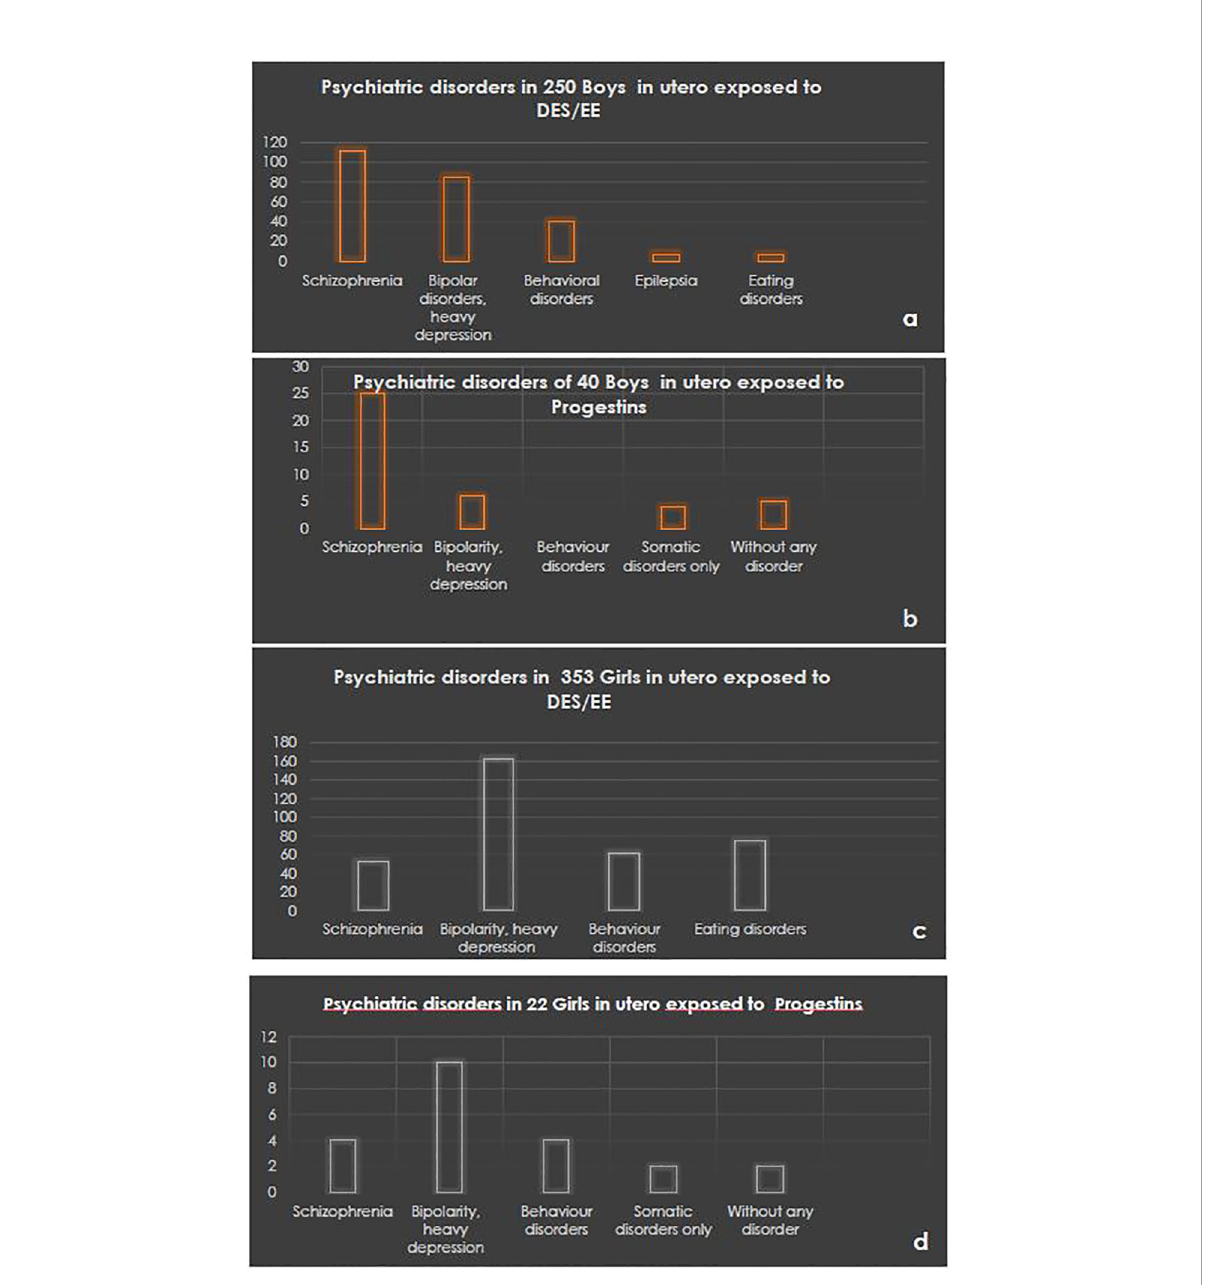
FIGURE 1 Psychiatric disorder rates in boys in-utero exposed to DES/EE (A) or to progestins (B) and in girls exposed to DES/EE (C) or to progestins (D) . © Hhorages-France